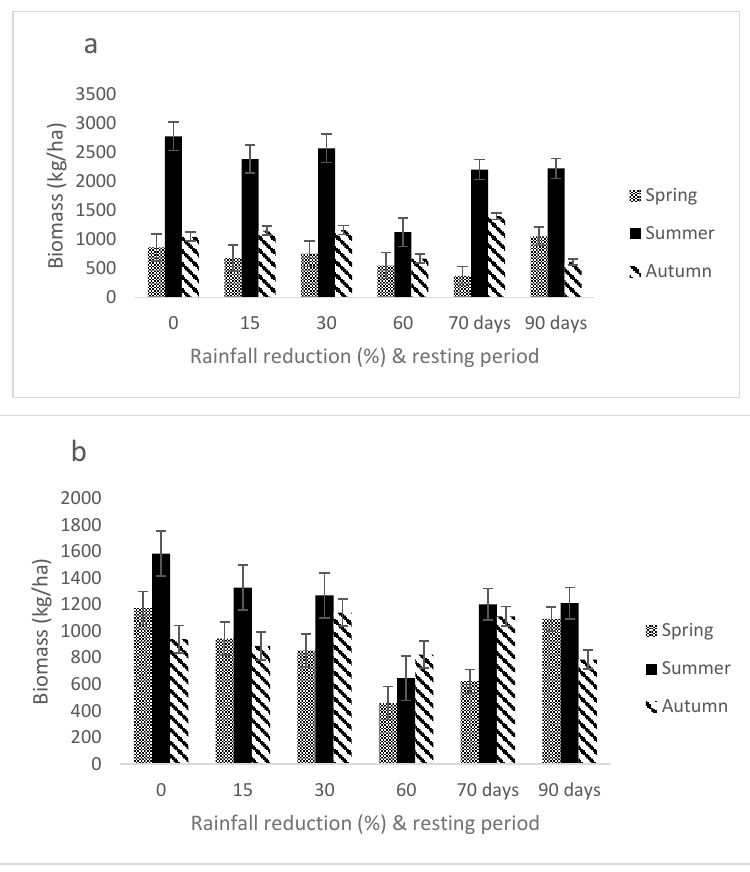
Figure 5. Interaction effect of resting period and rainfall reduction on overall aboveground biomass yield (kg. ha − 1 ) in ( a ) 2016/17 and ( b ) 2017/18 (bars indicate standard error values).